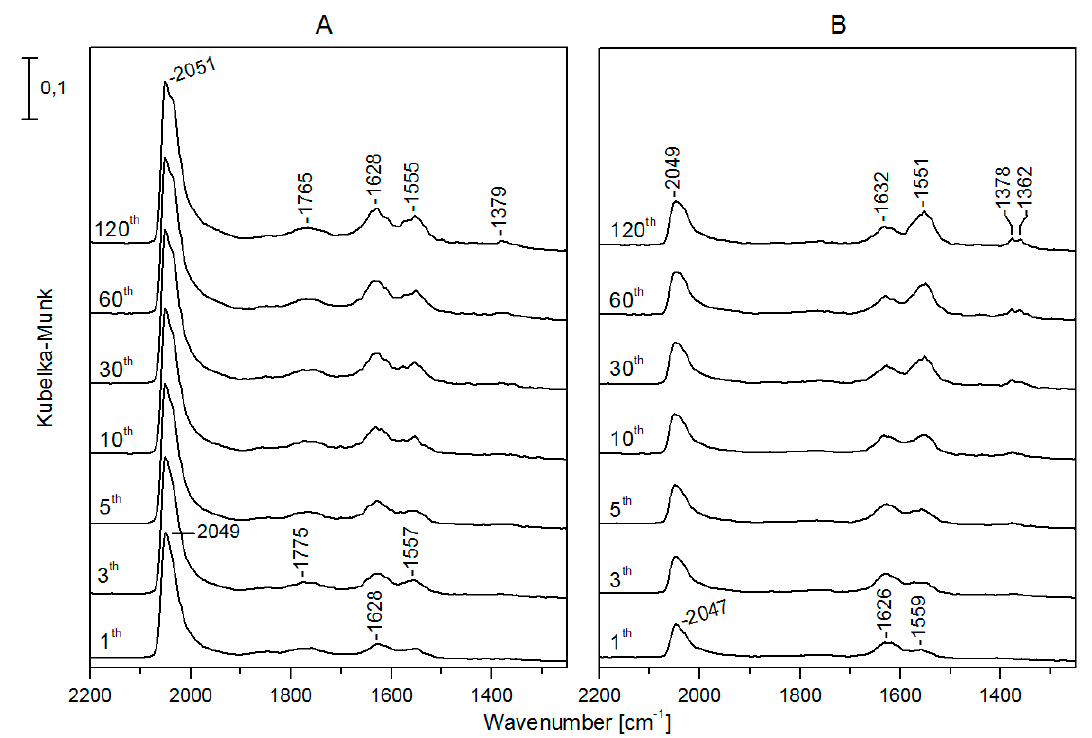
Figure 9. Infrared spectra registered during CO 2 + H 2 reaction at 493 K on Rh / TiONW ( A ) and Au-Rh / TiONW ( B ). The spectral labels indicate the time (in minutes) passed since the beginning of the reaction.